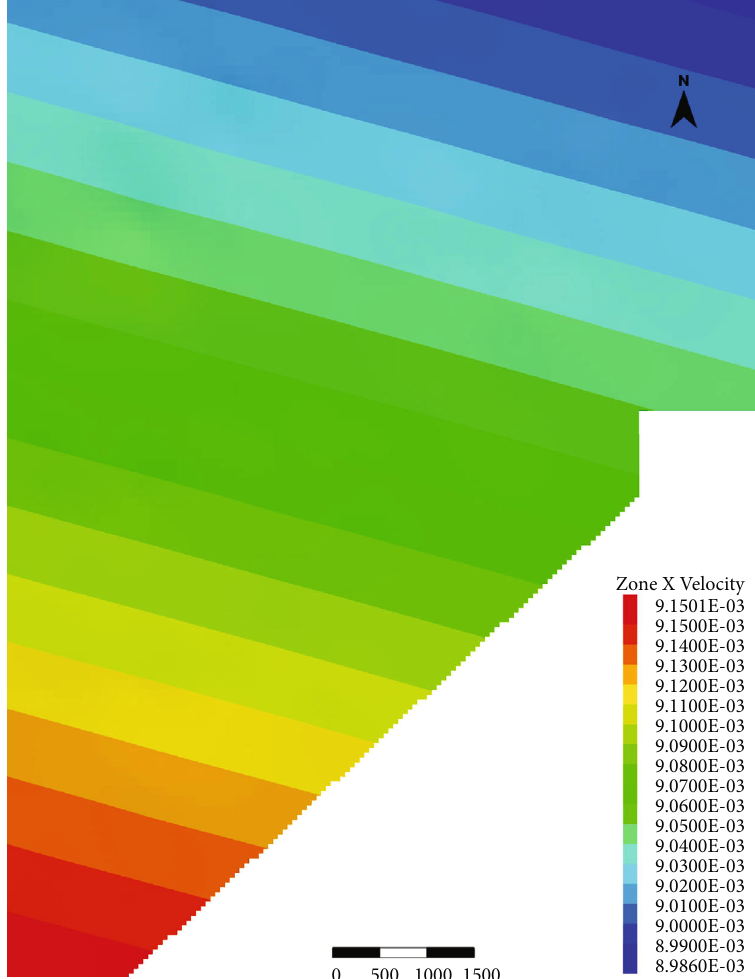
Figure 5: East velocity isogram in the model after applying tectonic stress